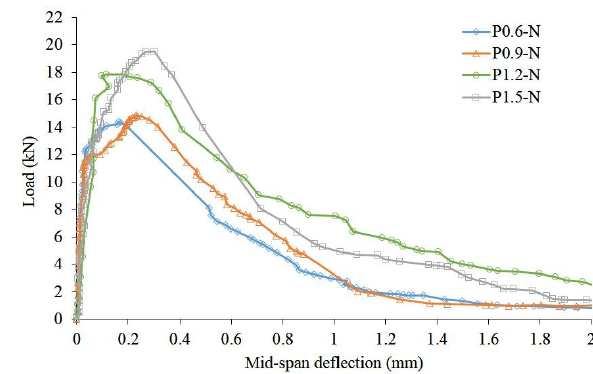
Figure 5: Load vs. mid-span deflection for composites with different